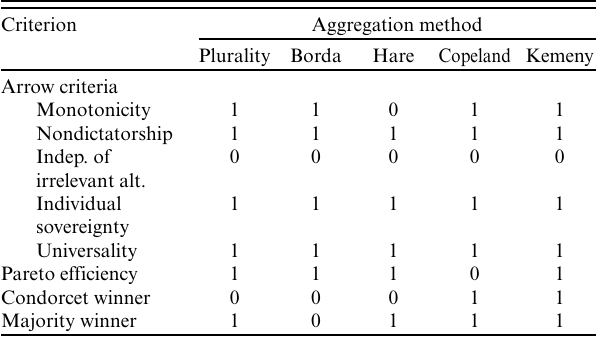
Table 2 . The criteria satisfied by each of the considered aggregation